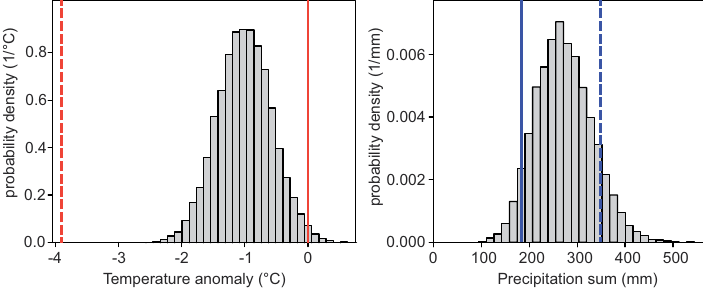
Fig. 8. Histogram showing 10000 artificial temperature anomaly averages (left panel) and precipitation sums (right panel) for the summer of 1816 based on weather types for 1816 and sampling from these weather types in the reference period. The dotted and solid lines denote the observed values for the year 1816 and the reference period, respectively.